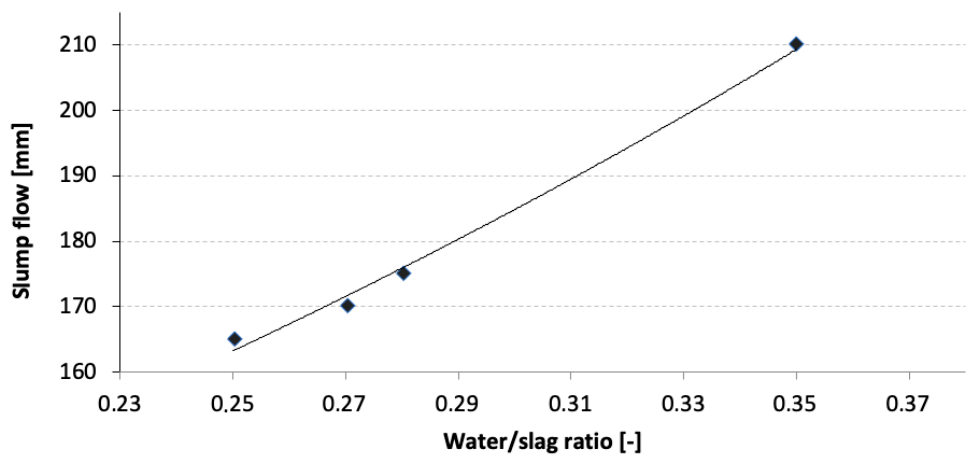
Figure 1. Paste flow as a function of water/slag ratio.